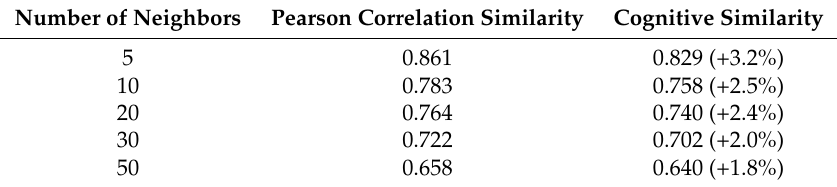
Table 3. Comparison between CF-Pearson Correlation Similarity and the CF-Cognitive Similarity with varying neighborhood sizes (MAE